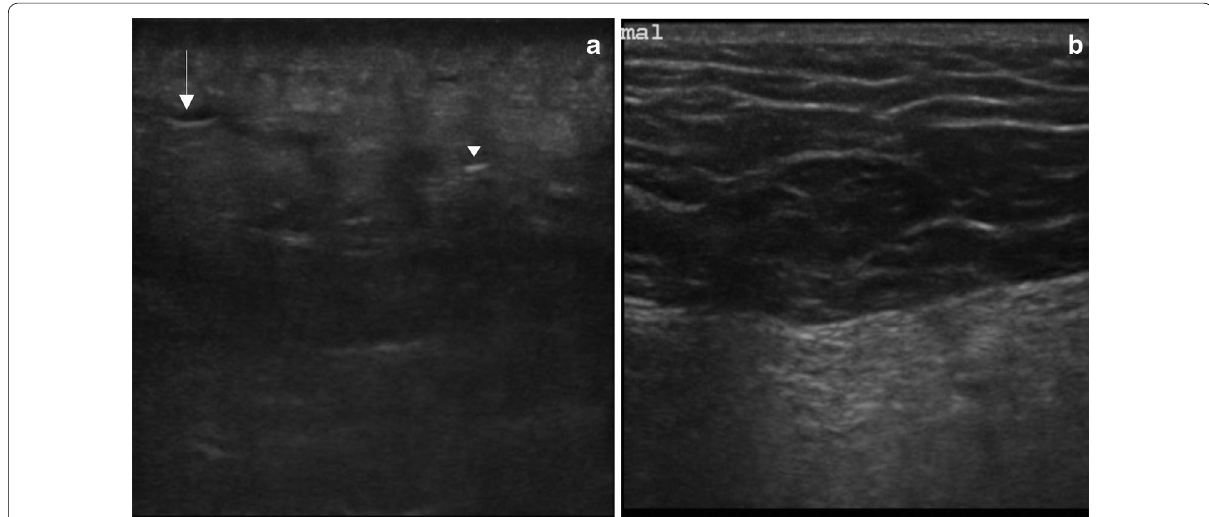
Fig. 2 Point-of-care ultrasound scan of the affected left gluteal soft tissue ( a ) and normal soft tissue on the contralateral side ( b ) using a 15–6 MHz linear probe. In the affected tissue, there is loss of the normal subcutaneous architecture, diffuse increased echogenicity, hypoechoic regions that correspond to little fluid accumulations (arrow) and an hyperechoic focus with posterior dirty acoustic shadowing, corresponding to gas in the soft tissue (arrowhead)